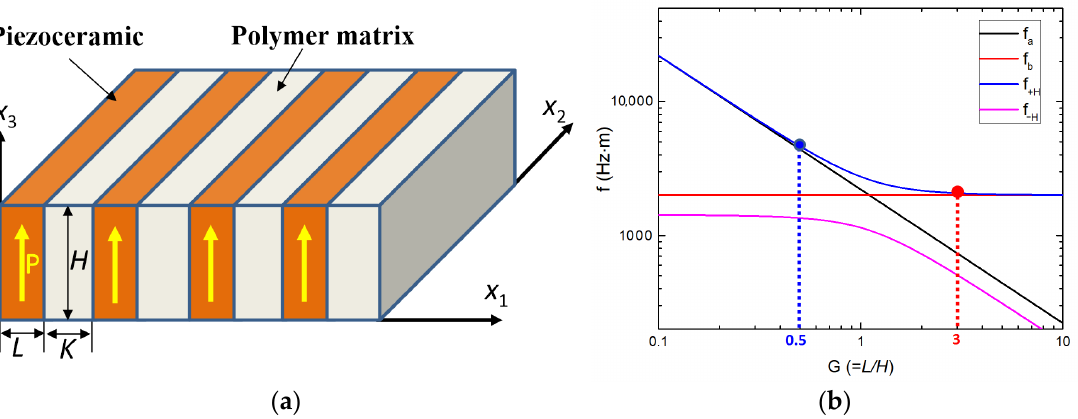
Figure 1. ( a ) Configuration of the 2-2 composite investigated in this study; ( b ) theoretical curves of the coupled and uncoupled resonance frequency as a function of G.